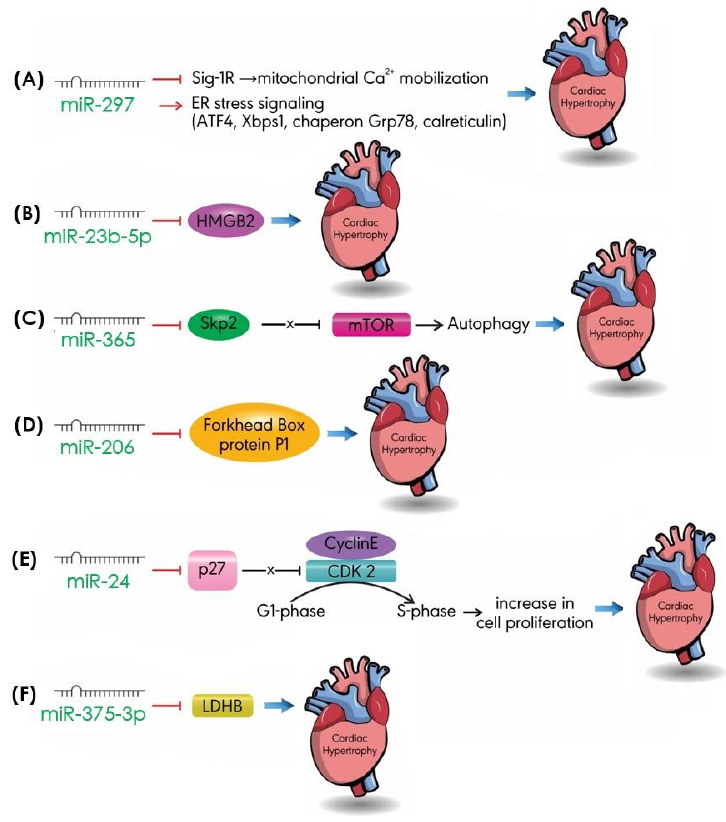
Figure 7. Pro-hypertrophic miRNAs augment cardiac hypertrophy by targeting different pathways: ( A ) miR-297 inhibits the expression of Sig-1R and activates ER stress signaling; ( B ) miR-23b-5p represses HMGB2 expression; ( C ) miR-365 downregulates the expression of Skp2; ( D ) miR-206 negatively regulates the expression of Forkhead box protein P1; ( E ) miR-24 targets p27 and reduces its protein expression; ( F ) miR375-3p abrogates the expression of LDHB. ER: endoplasmic reticulum; HMGB2: high-mobility group box 2; LDHB: lactate dehydrogenase B chain; Sig-1R: sigma-1 receptor; Skp2: S-phase kinase-associated protein 2.